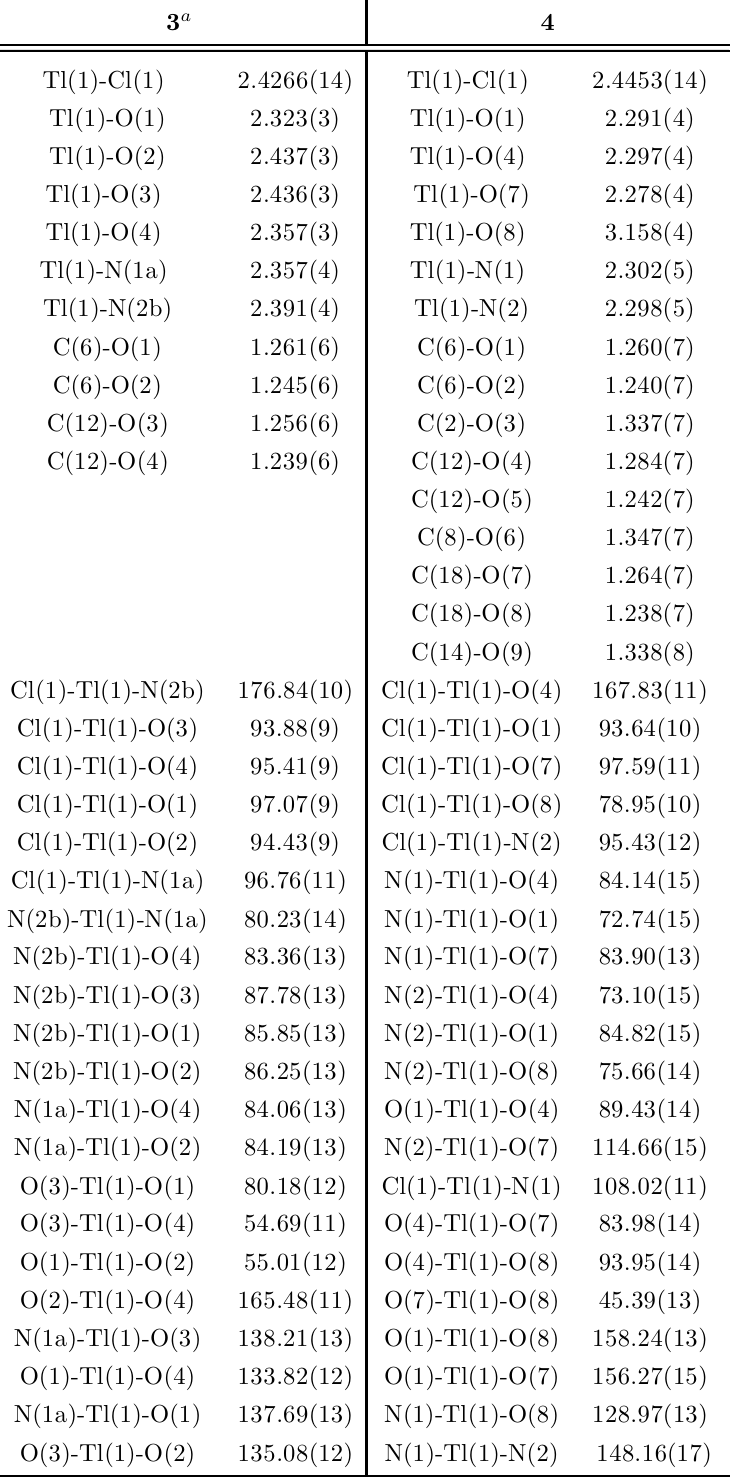
Table 5 Selected bond lengths (¸A) and angles (deg.) for compounds 3 and 4 . a Symmetry equivalent atoms (-x+1, y+1/2, -z+1/2 and x-1/2, -y+1/2, -z) given by a \a" and